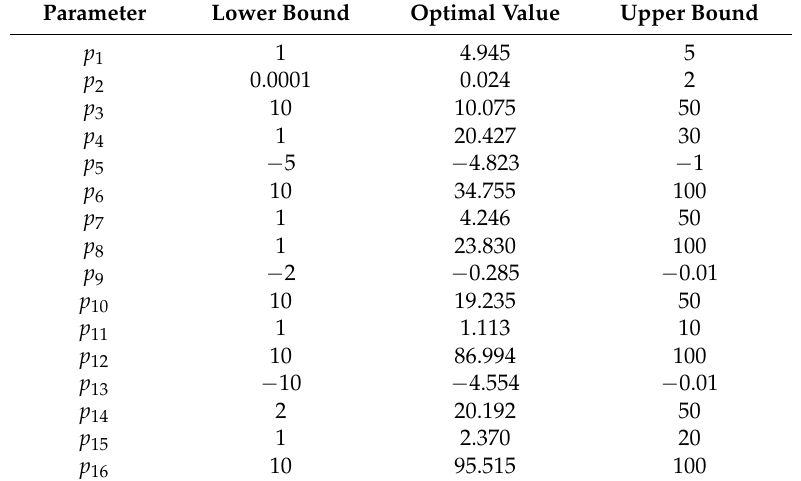
Table 2. The lower bounds, upper bounds, and optimal values of the identified